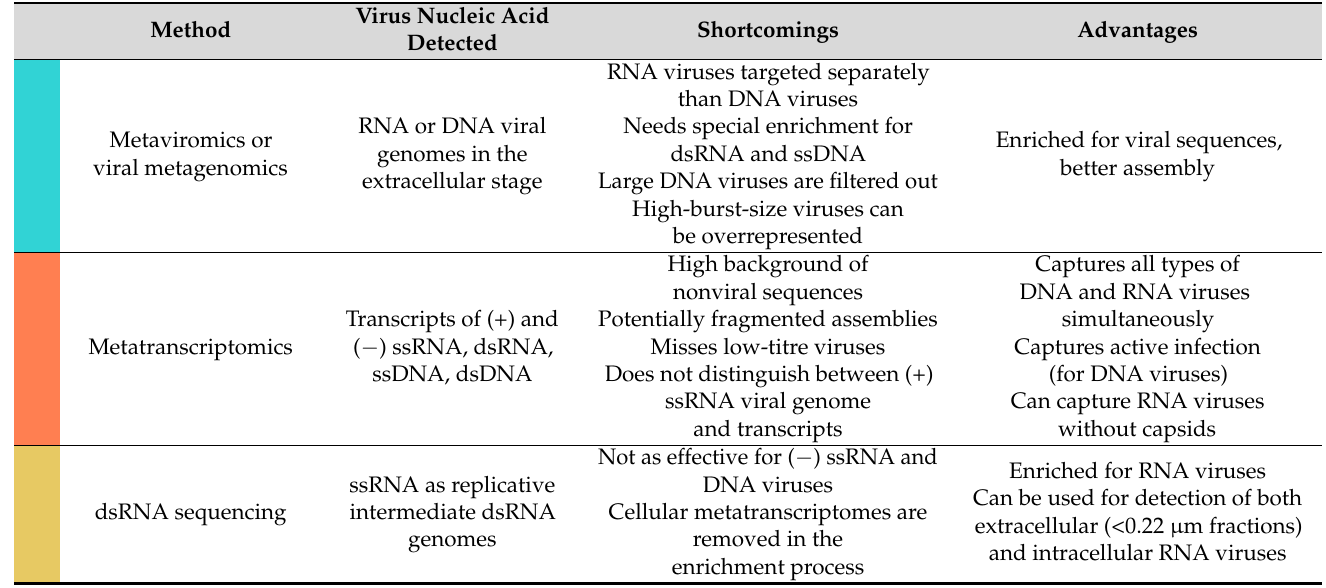
Table 1. Advantages and shortcomings of the meta-omic sequencing approaches used in marine viral ecology studies. Adapted from